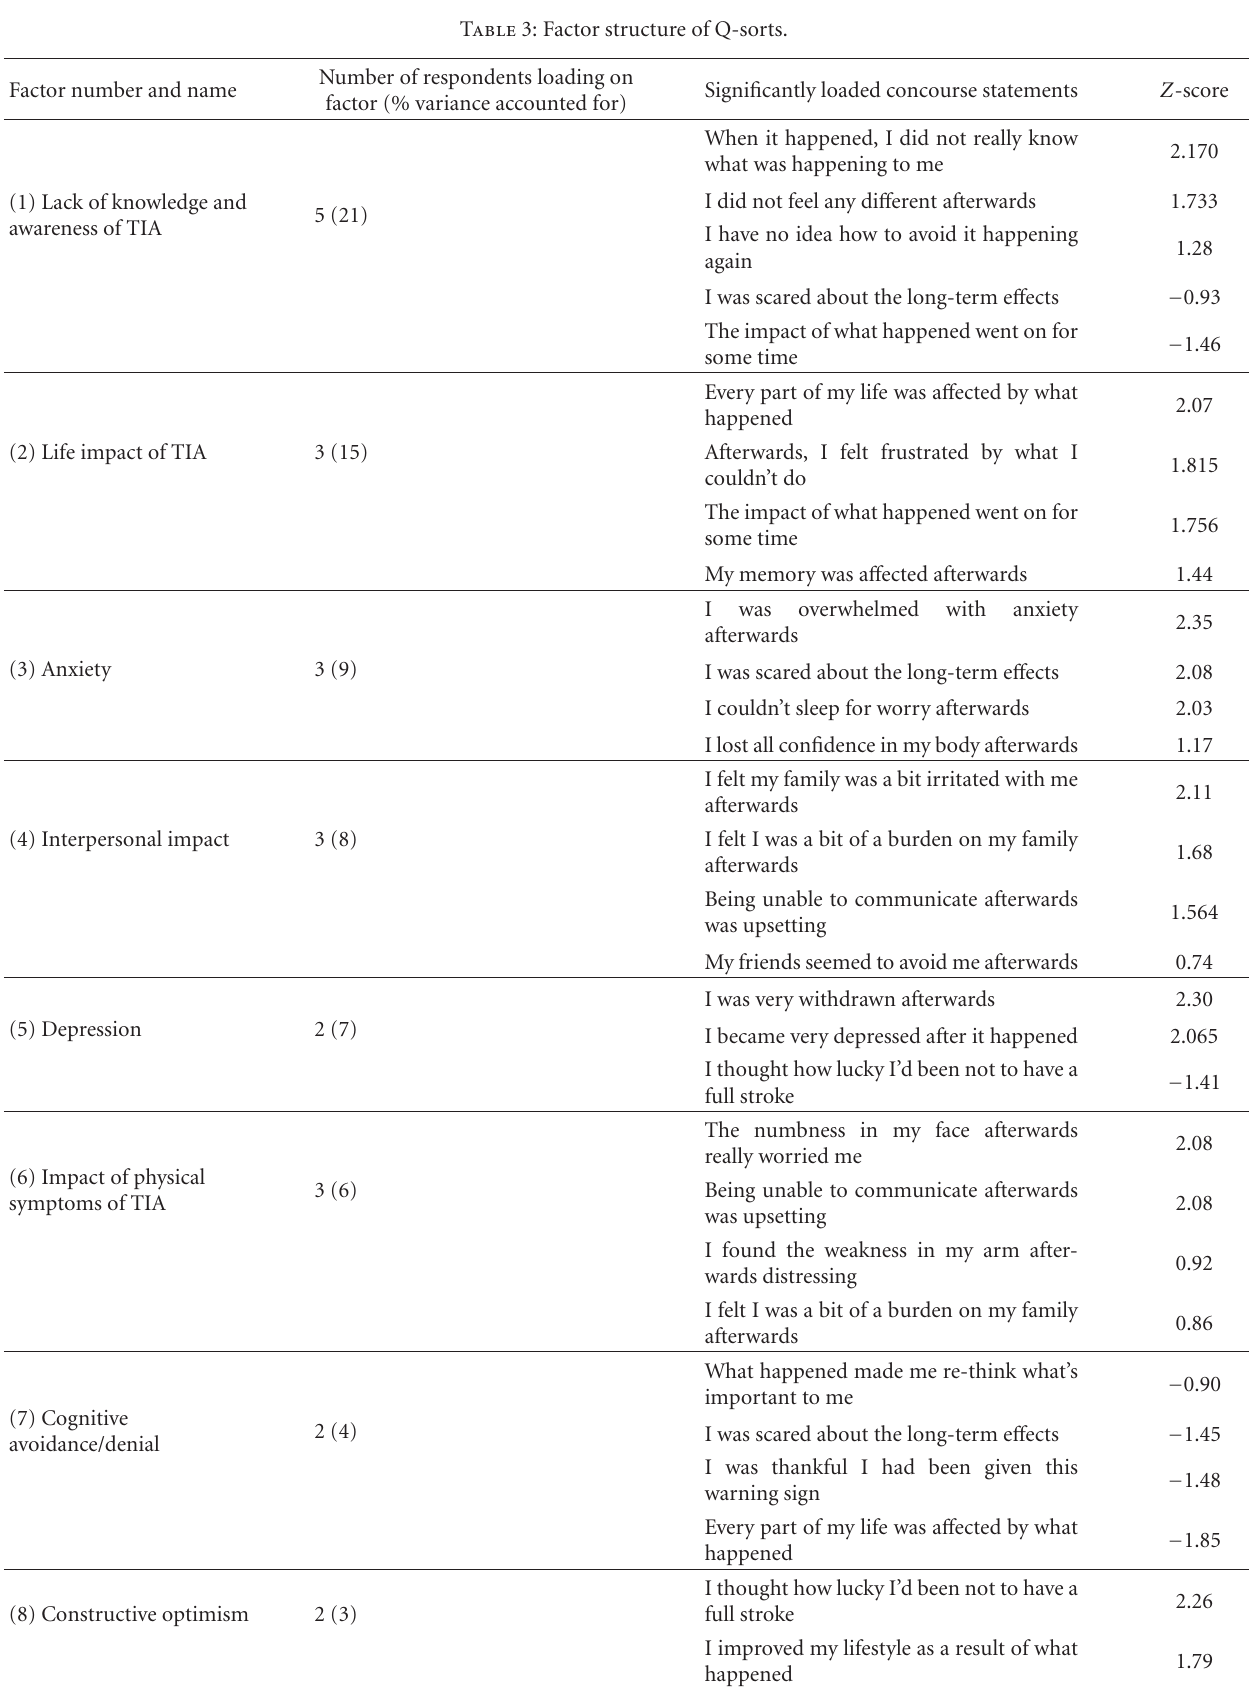
Table 3: Factor structure of